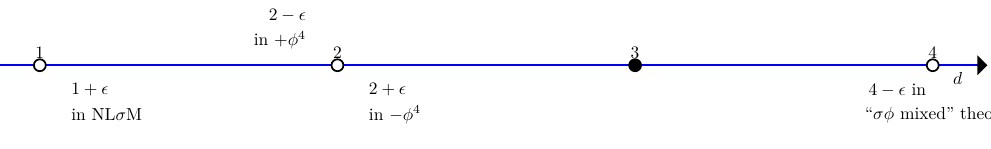
Figure 1 . O( N ) BCFT in 1 < d <